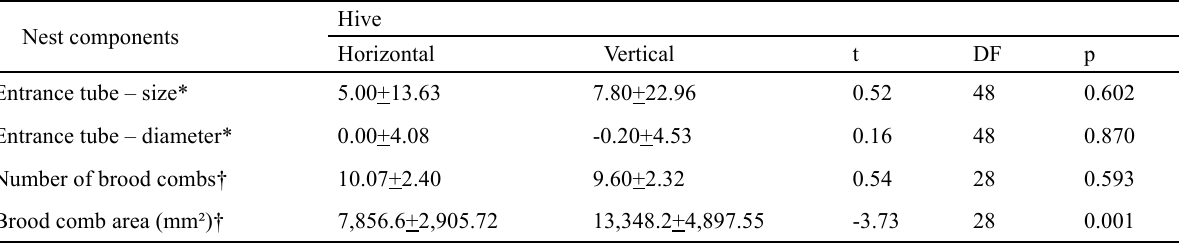
Table 1 . Comparisons (means ± SD) of the nest components of Scaptotrigona aff. postica colonies housed in two different hive models: Vertical and Horizontal, August/2013 to January/2014. Comparisons were made through an independent